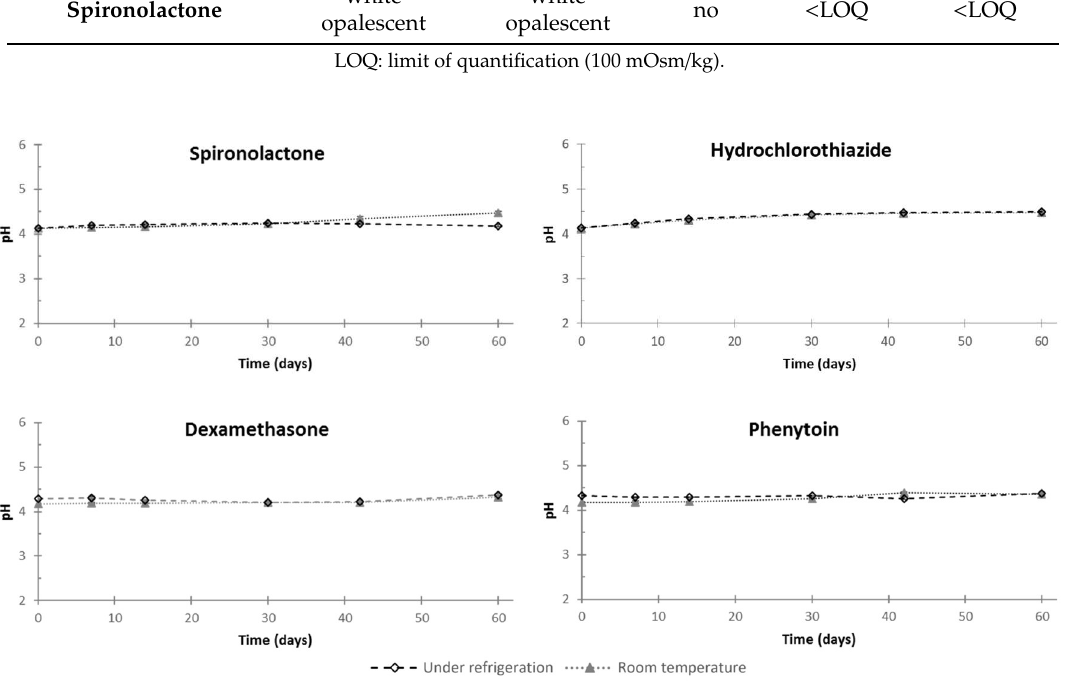
Table 5. Physical parameters assessed during the stability study of dexamethasone, hydrochlorothiazide, phenytoin, and spironolactone oral suspensions regardless of the type of storage conditions used (under refrigeration or at room temperature).